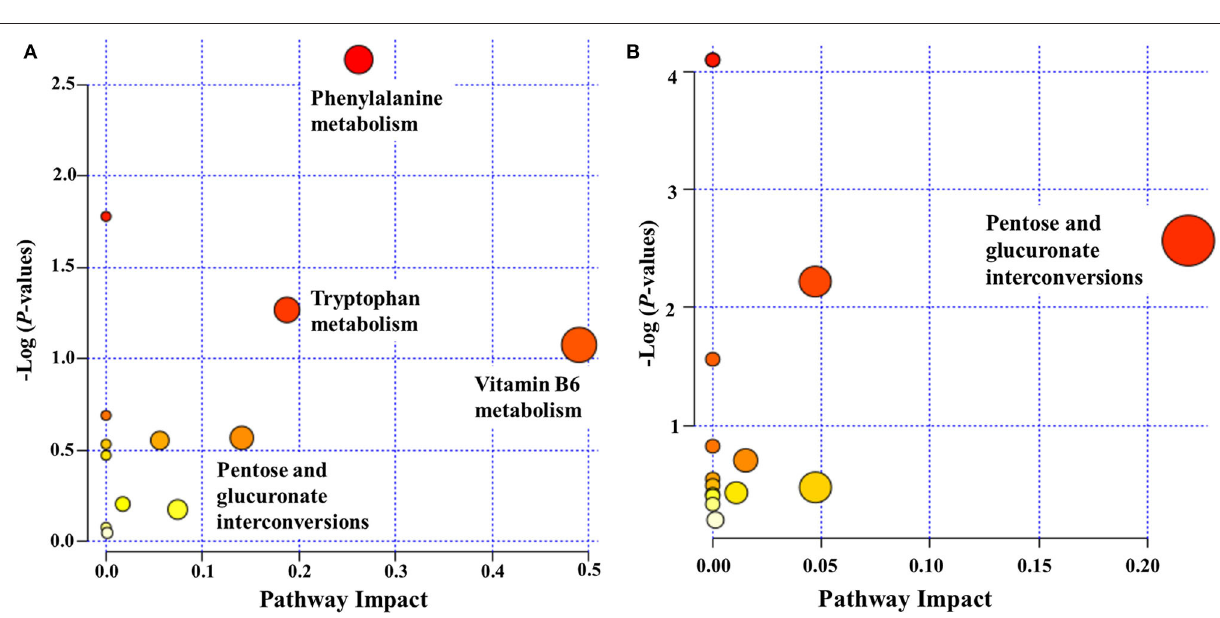
FIGURE 5 | Functional classification of differentially accumulated metabolites between ASD and TD groups in positive ion mode (A) and negative ion mode (B) . The “metabolome view” shows the pathway impact on the X-axis vs. the negative log ( P -value) on the Y-axis for the metabolic pathways. The pathways that were most significantly changed are characterized by both a high-log (P) value and a high-impact value (top right